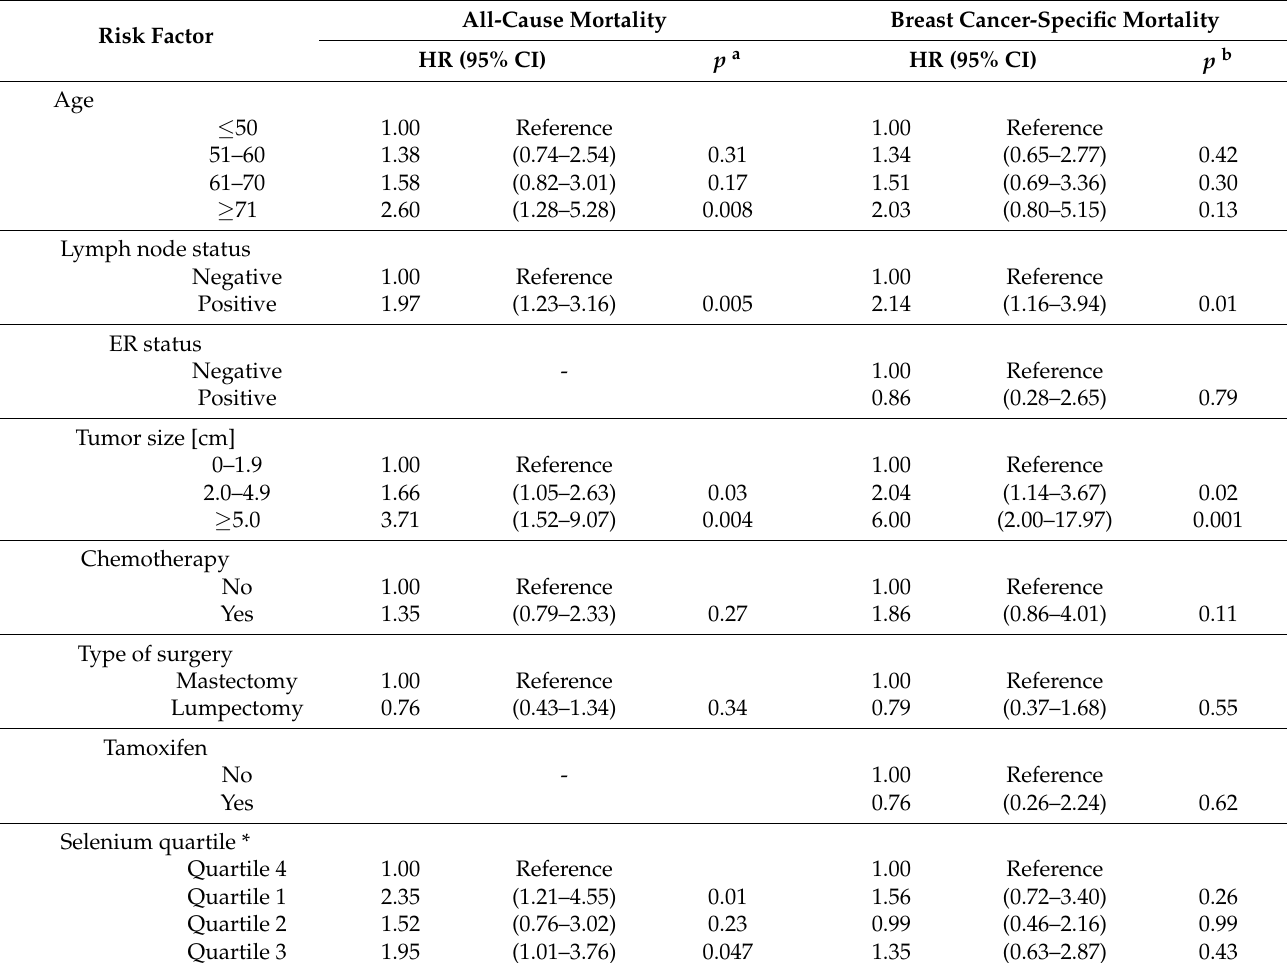
Table 4. Hazard ratio (HR) and 95% confidence intervals (CI) of all-cause and breast cancer-specific mortality by various treatments and clinical characteristics multivariate